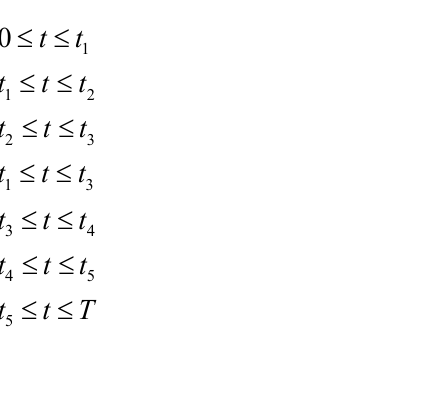
Fig. 1. Two warehouse model with the shortages at the